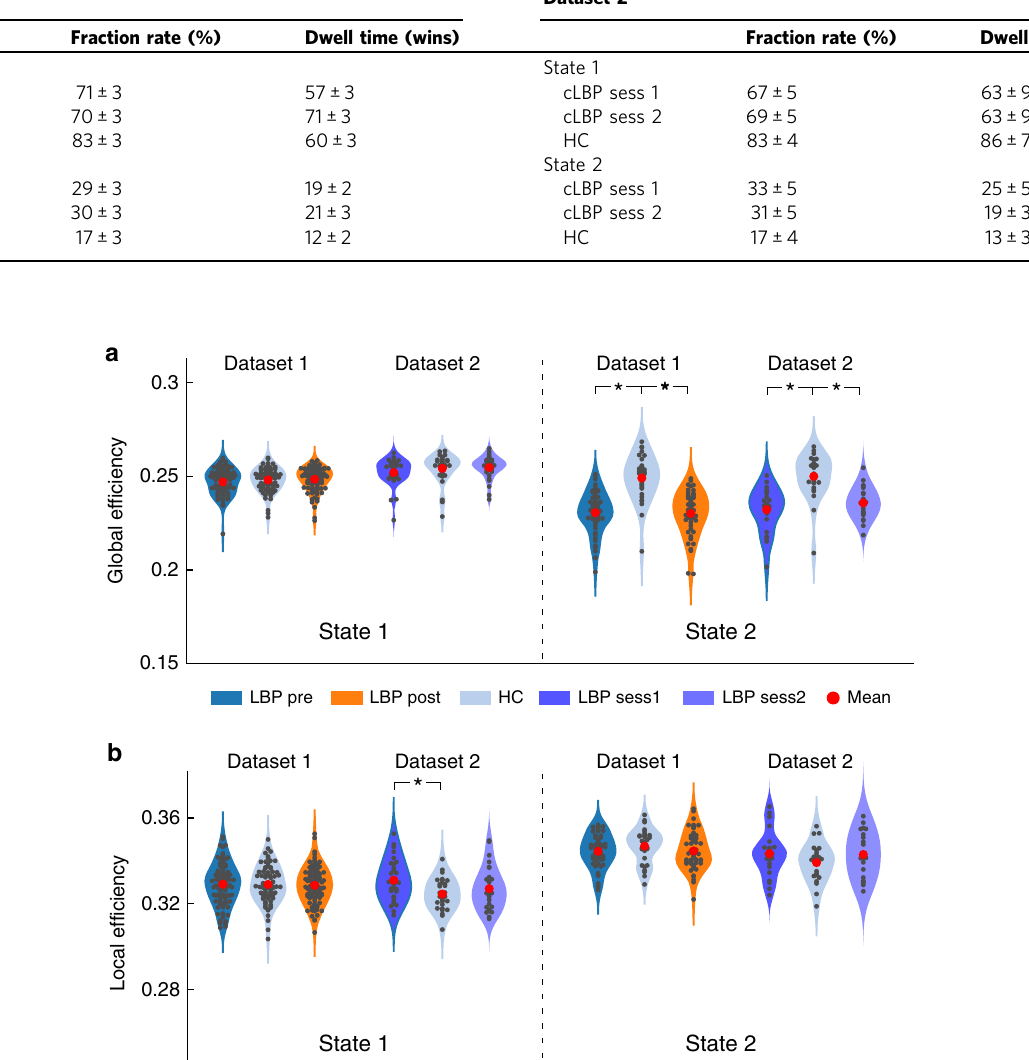
Table 2 Fraction rate and dwell time (mean ± SEM) for cLBP patients and HCs in two datasets. Dataset 1